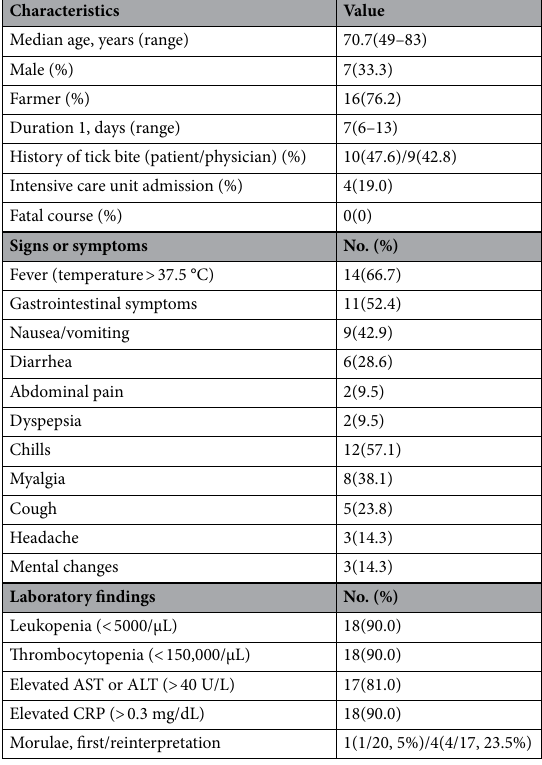
Table 1. Patient characteristics, clinical manifestations, and lab findings. AST aspartate aminotransferase, ALT alanine aminotransferase, CRP C-reactive protein, No number. Duration 1 is the days from the symptom onset to the initial visit (days). History of tick bite means tick bite site cognition by patient or physician. Laboratory findings are reported with the samples on the admission day. Morulae initially checked as a reported paper by the first interpretation and reviewed using peripheral blood smear slides for reinterpretation.